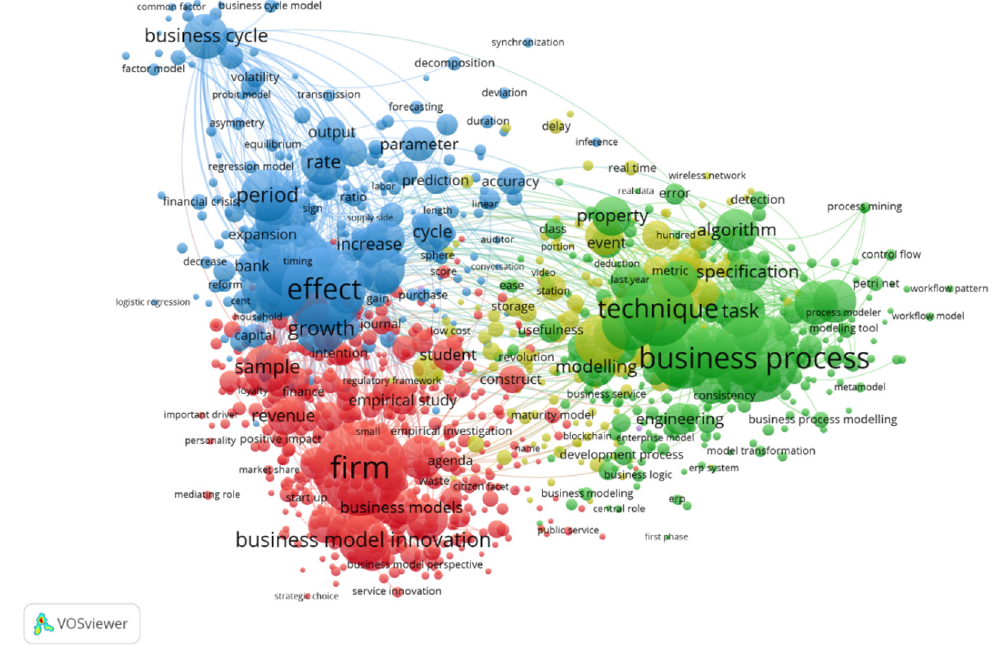
Figure 6. Historiographic map of scientific publications on “business models and Industry 4.0” from 1 January 1996 to 30 October 2021.